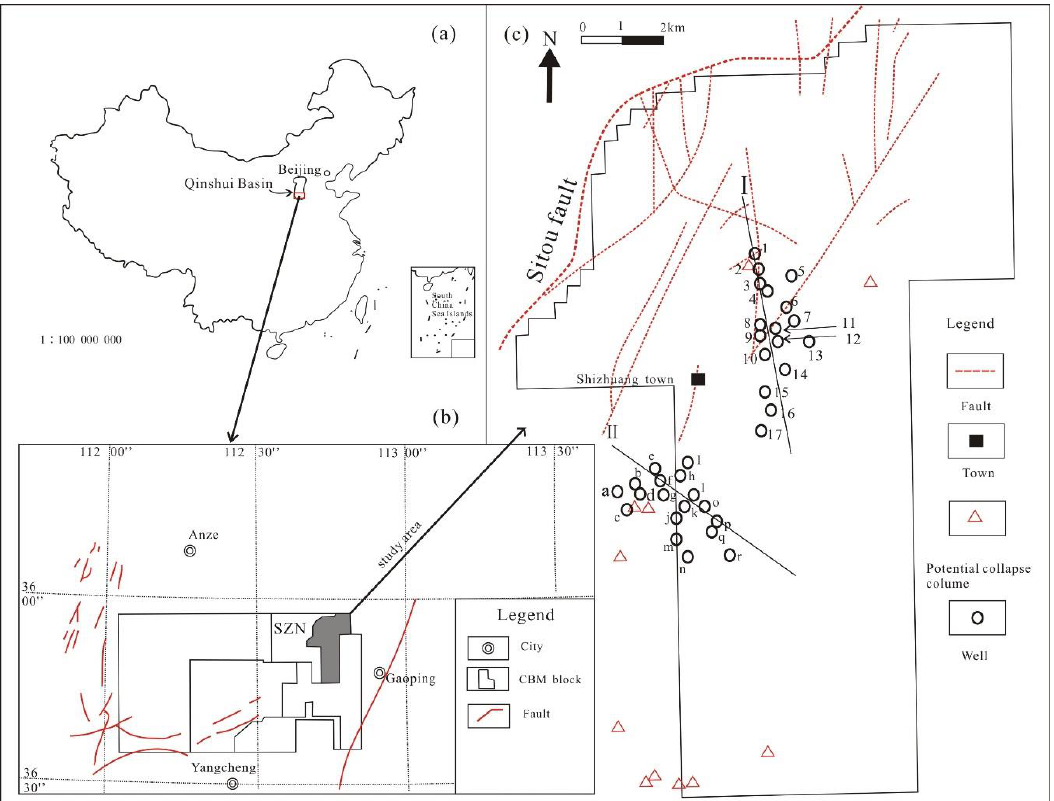
Figure 1. Location of study area and sampling sites: ( a ) location of the Qinshui Basin in China; ( b ) location of the Shizhuangnan block in the Qinshui Basin (SZN, the Shizhuangnan block); ( c ) location of sampling sites in the Shizhuangnan block.